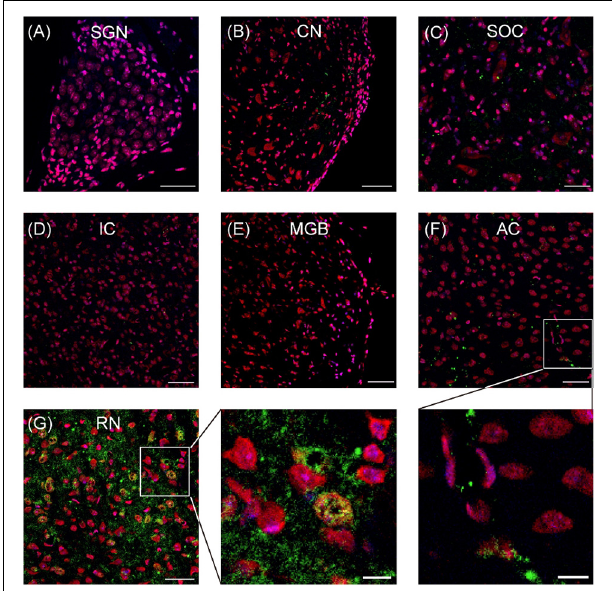
FIGURE 1 | Representative images show the serotonin transporter (SERT) expression in different regions of auditory system. (A–G) Confocal images show the SERT (green) expression in the spiral ganglion neurons (SGN), cochlear nuclei (CN), superior olivary complex (SOC), inferior colliculus (IC), medial geniculate body (MGB), auditory cortex (AC), and raphe nuclear complex (RN). Insets are the magnified images of the boxes in (F,G) . The soma and nucleus of neurons are colored in red (Nissl) and blue (DAPI), respectively. SERT is colored in green. Scale bars: 50 µ m for (A–G) and 10 µ m for